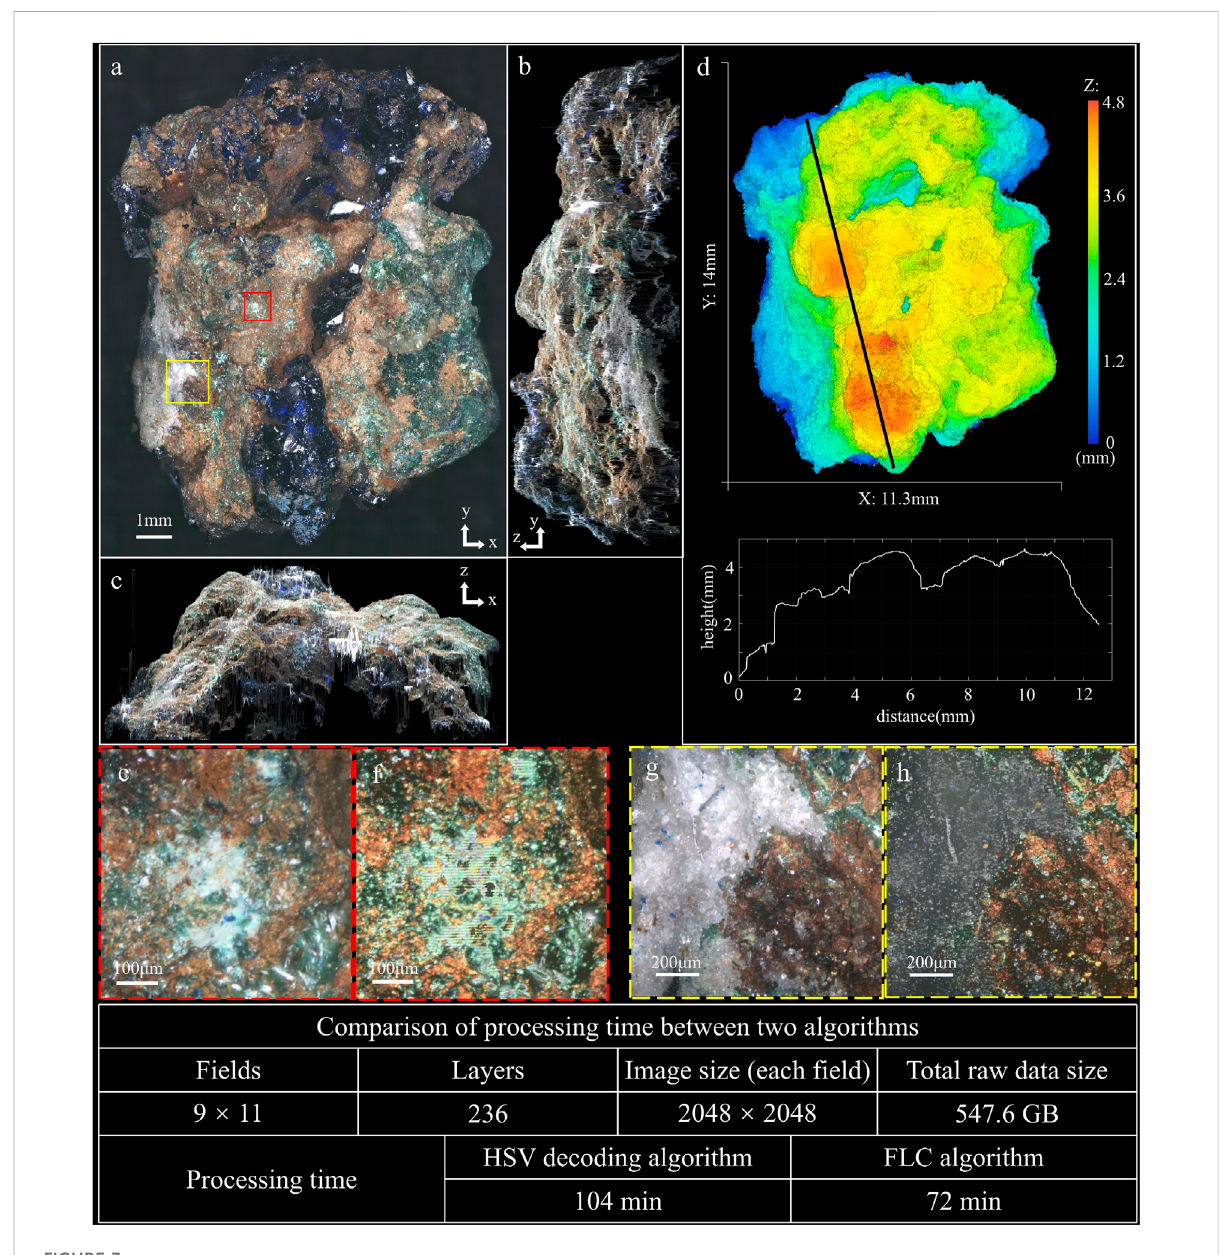
FIGURE 3 3D imaging result of azurite(see SupplementaryVideo S1). (A) MIP imagealong z axis. (B) MIP imagealong x axis. (C) MIP image along y axis. (D) Height map of thesample, with thepro fi le along theblack line-scan. (E) Detail imageof themalachite in (A) . (F) Imagerestored bytheHSV